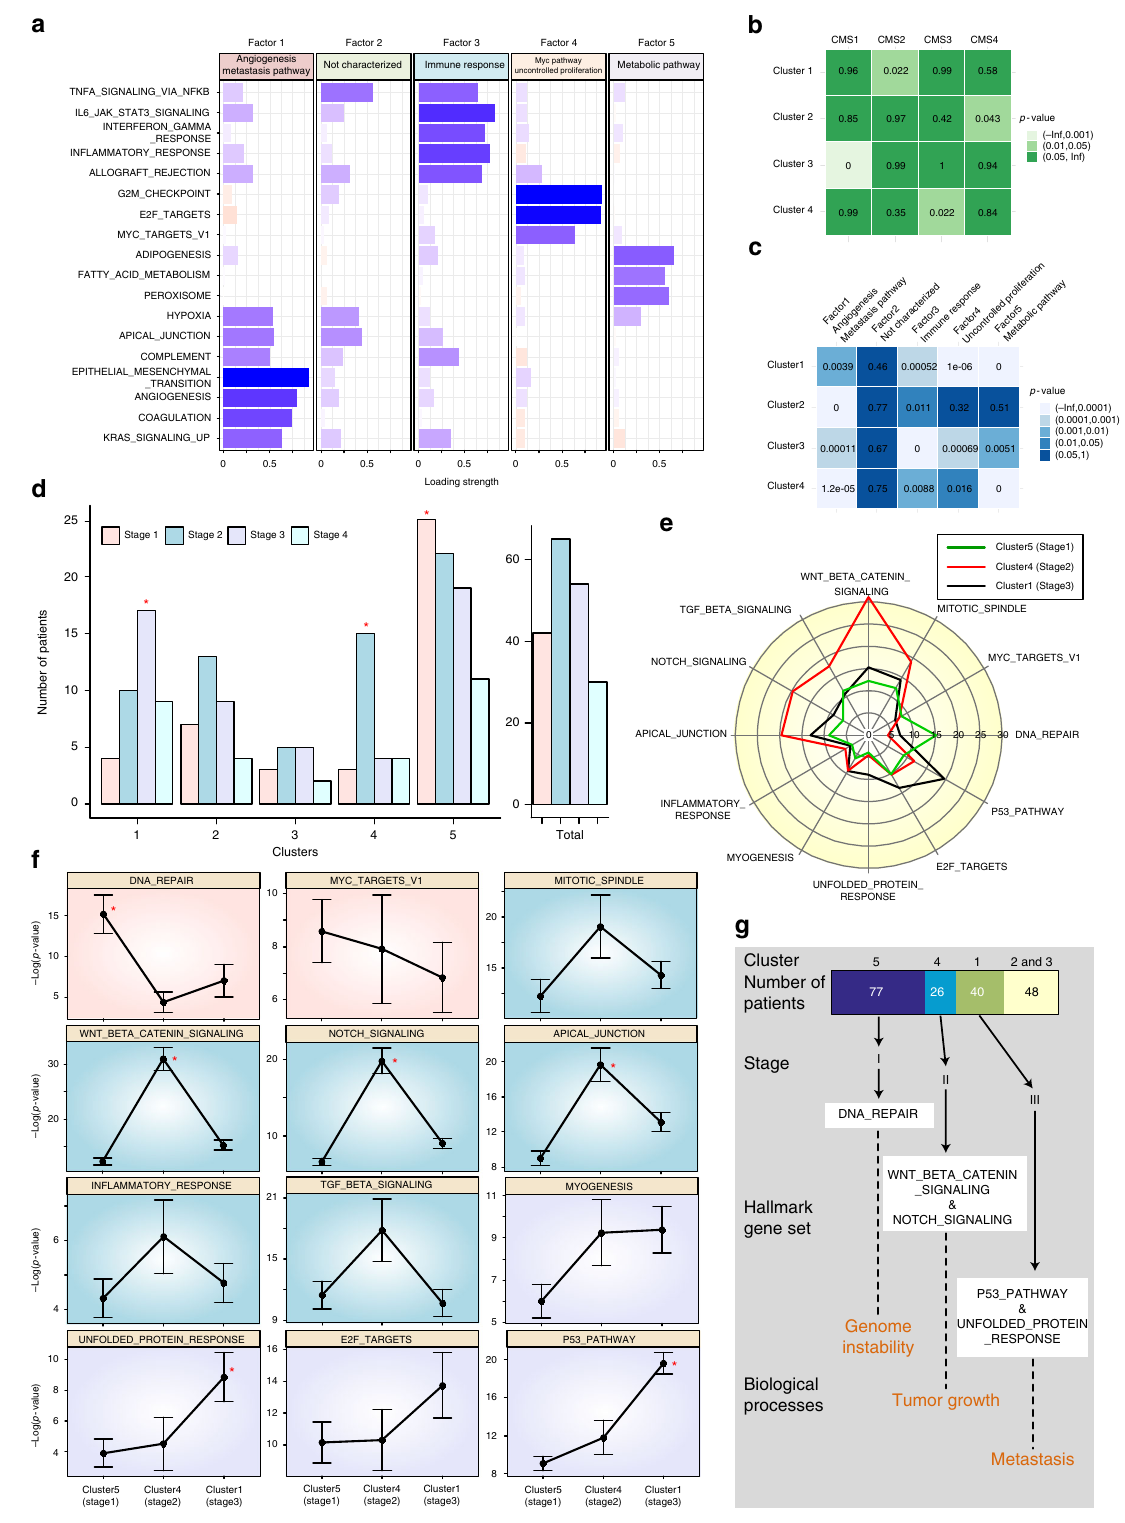
which Factors are dominant in each cluster (Fig. 4c) and compared the results with the biological signatures of the CMS groups 25 . Cluster 1 was mainly characterized as Factor 4 (Myc pathway and uncontrolled proliferation) and Factor 5 (metabolic pathway), while Factor 1 (angiogenesis and metastasis